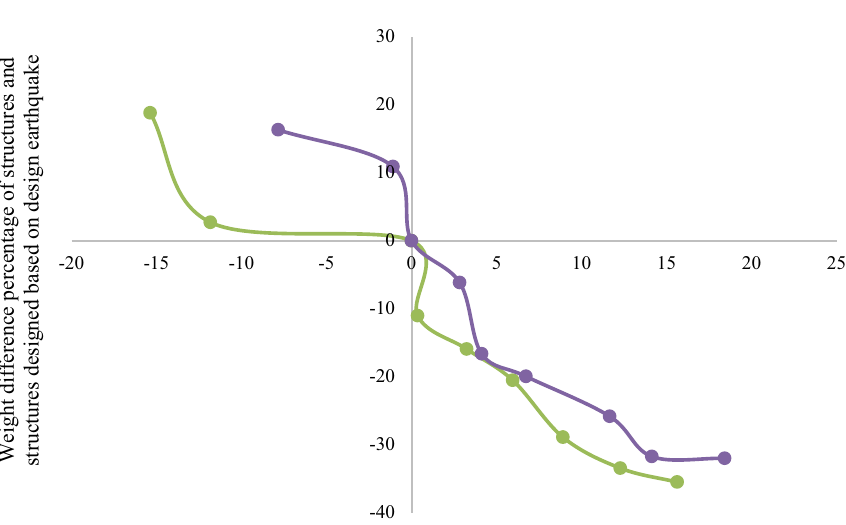
-40 Weight difference percentage of structures and structures designed based on design earthquake 10 Story - Regular 10 Story - Irregular Figure 11. Weight and LCC difference of 10-story models based on the design earthquake (in